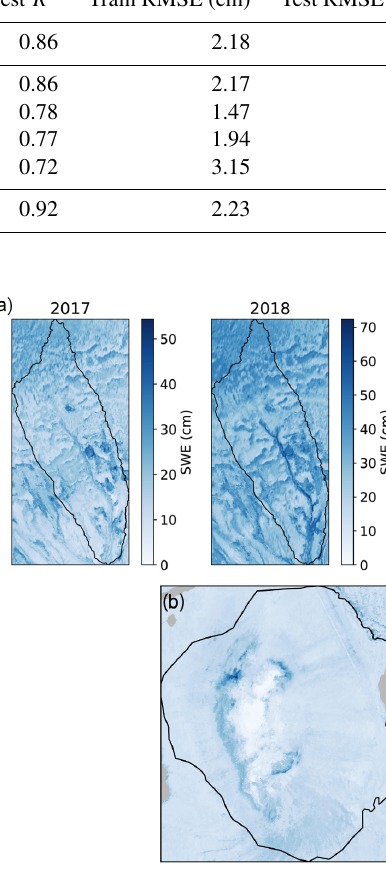
Figure 7. Random forest results of predicted SWE vs. actual SWE for the test set when using all year and site datasets, with a test set of 20%. R 2 is equal to 0.86, and the RMSE is equal to 5.81cm. The solid blue line is a linear fit to the scattered points, and the dashed black line is a y = x line.